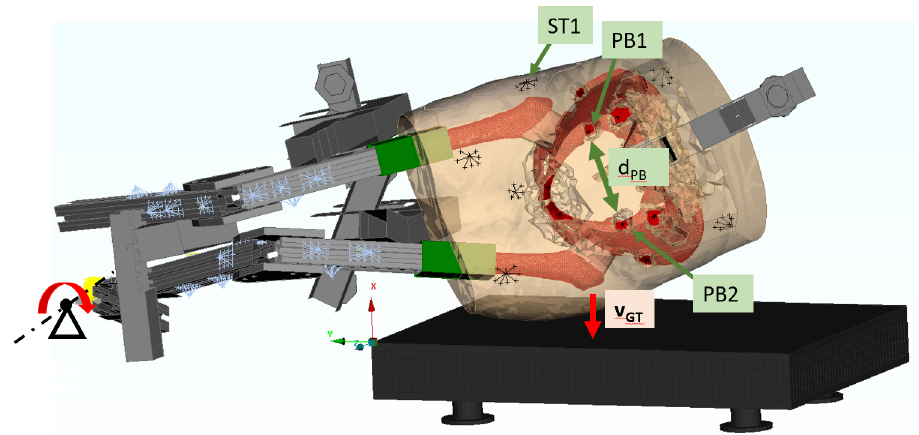
Fig 2. FEM of specimen H1391 aligned in initial position corresponding to the time of first contact with force plate during the experimental testing. Lower limb constructions coloured grey, lower limb masses coloured blue and soft tissue coloured orange. Marker points corresponding to location of video markers of the physical specimen are shown in black. Marker ST1 corresponds to a marker attached to the surrogate soft tissue above the right GT. Markers LR1 and LR2 correspond to the position of markers attached to the right and left side of the pelvic ring,